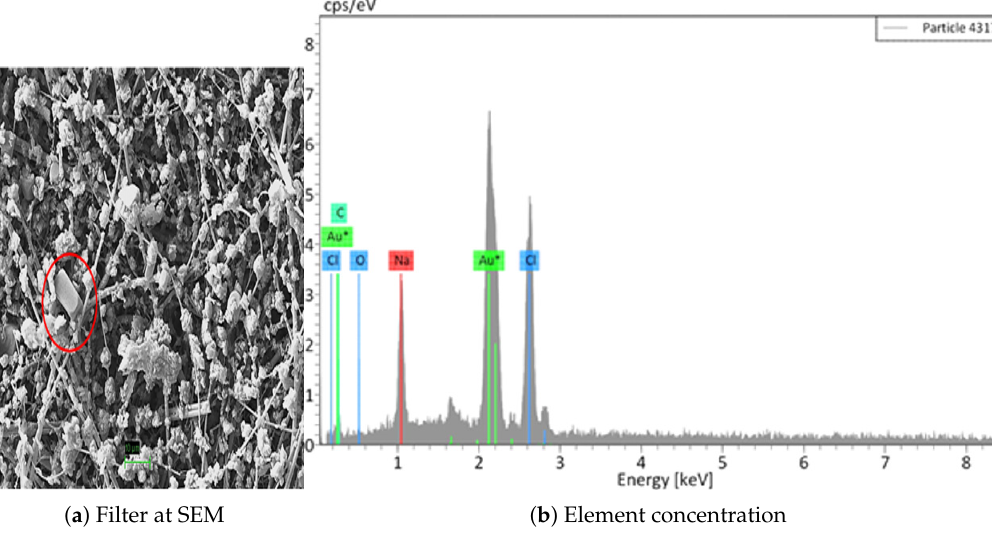
Figure 8. 14–17 April 2018 dust event magnified sampled filter image and elements